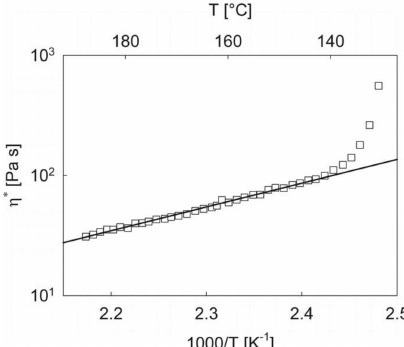
Figure 3. The logarithm of the complex viscosity as a function of the inverse absolute temperature in the early stages of the cooling ramp. The frequency is 10 rad/s. The straight line is the linear regression of the data before the jump due to the onset of the sol/gel transition (see Equation (1)). The linear temperature scale (in ◦ C units) is reported on the top x -axis to facilitate the